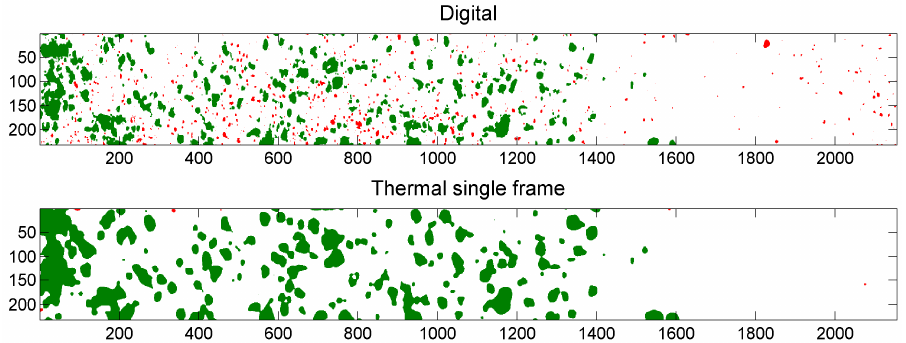
Figure 5. Binarized digital image ( top ); and binarized thermal output image “single frame” ( bottom ). Coordinates are shown in pixels. Particles that occur in both images are shown in green. Particles that occur only in the digital image or only in the thermal output image are shown in red in respectively the top image and the bottom image.